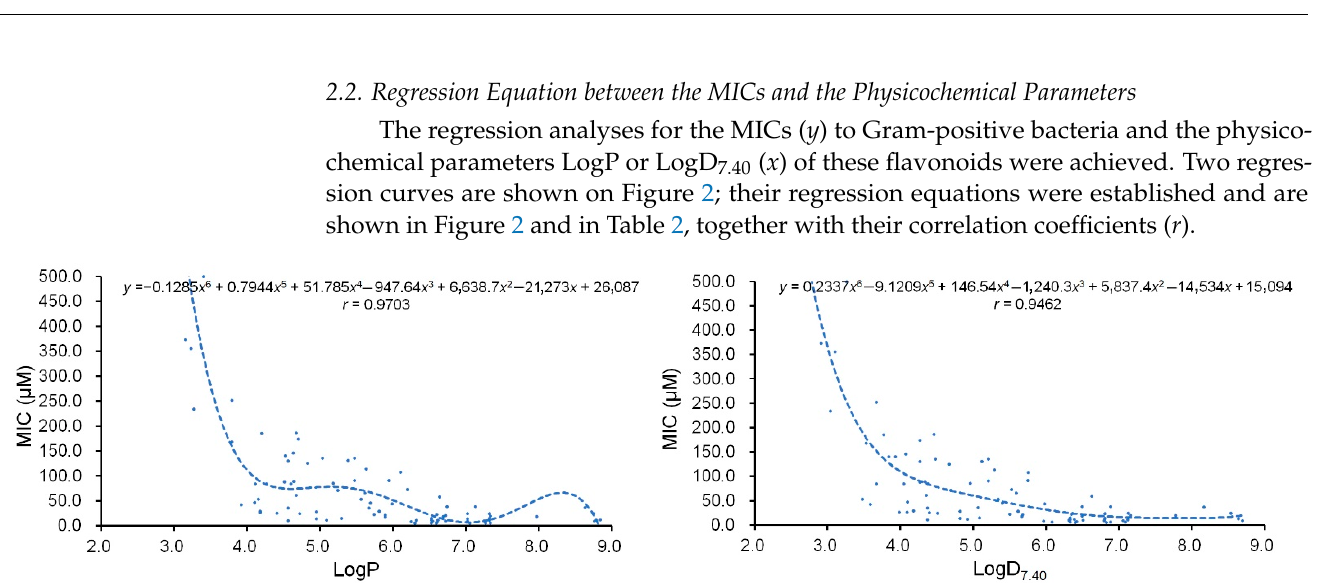
Figure 2. Polynomial regression analyses for the physicochemical parameter LogP or LogD 7.40 ( x ) and the MIC ( y ) to Gram-positive bacteria, mainly including Staphylococcus aureus , S. epidermidis , or/and Bacillus subtilis of 92 plant flavonoids. Table 2. Regression equations for the correlation between the physicochemical parameter ( x ) and the antimicrobial activity ( y ) to Gram-positive bacteria of plant flavonoids a .